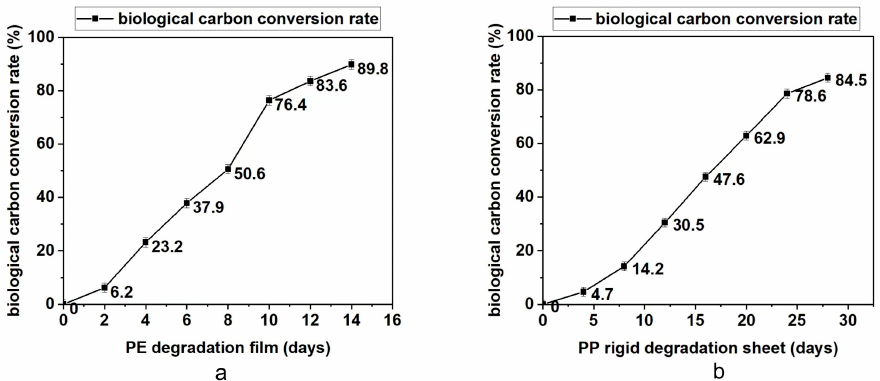
Figure 3. ( a ) Determination of carbonyl index during degradation of PE materials. ( b ) Determination of carbonyl index during degradation of PP materials.